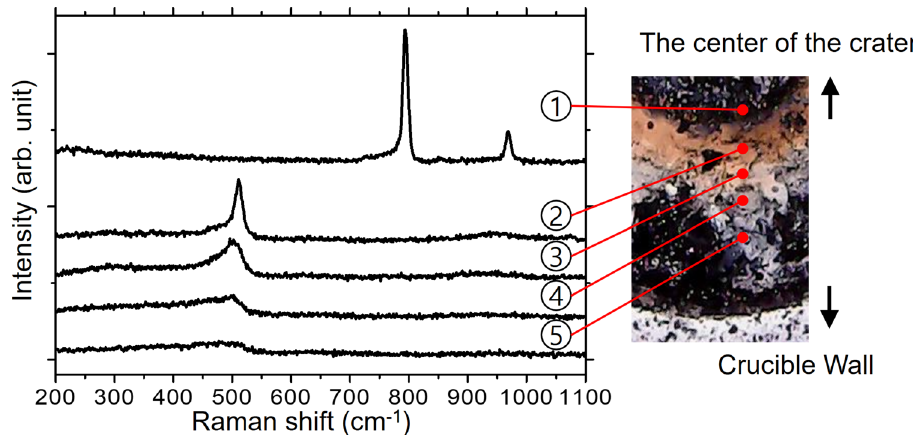
Figure 3. Raman spectra of the sample after 50 W laser beam